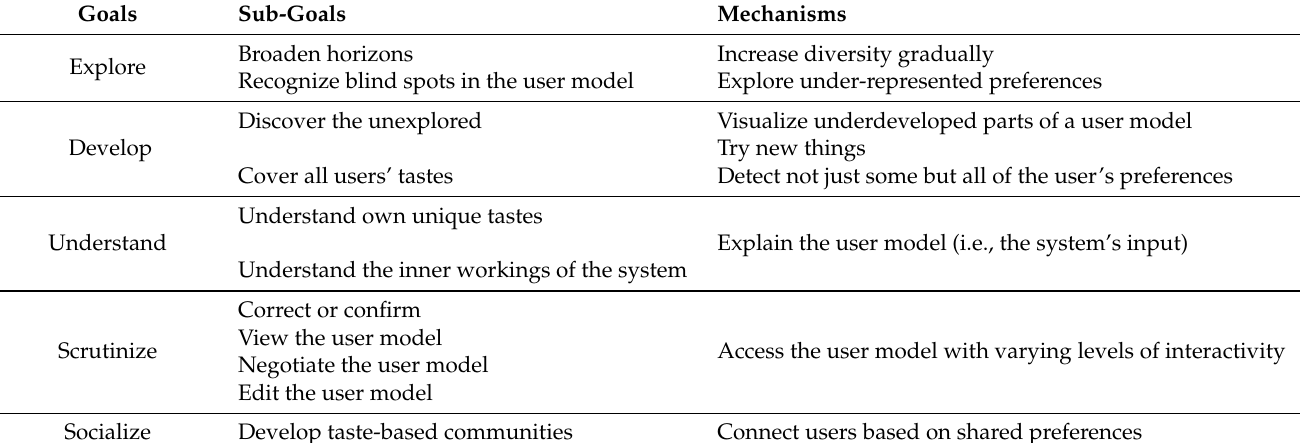
Table 3. A summary of self-actualization goals along with their related